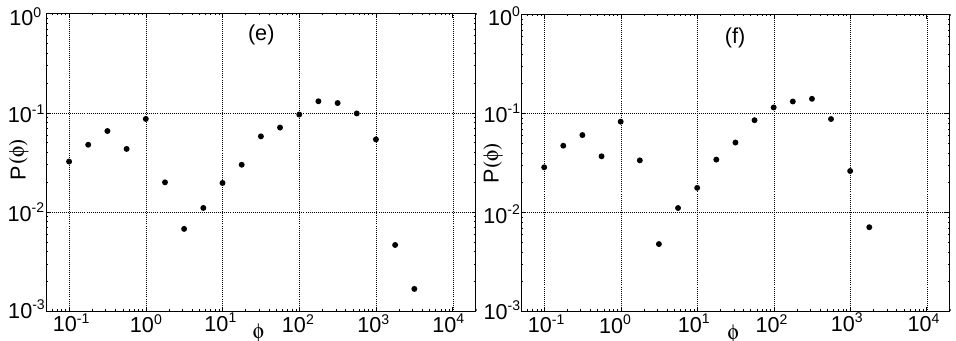
Figure 9. Distributions of the polarity intervals. The α -quenching by energy ( γ = 1). ( a ) ν = 2.0; ( b ) ν = 2.2; ( c ) ν = 2.3; ( d ) ν = 2.6; ( e ) ν = 2.8; ( f ) ν =